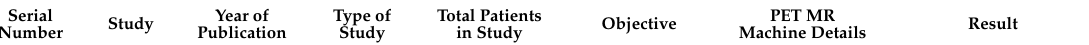
Table 5. Characteristics of PET/MRI studies in endometrial